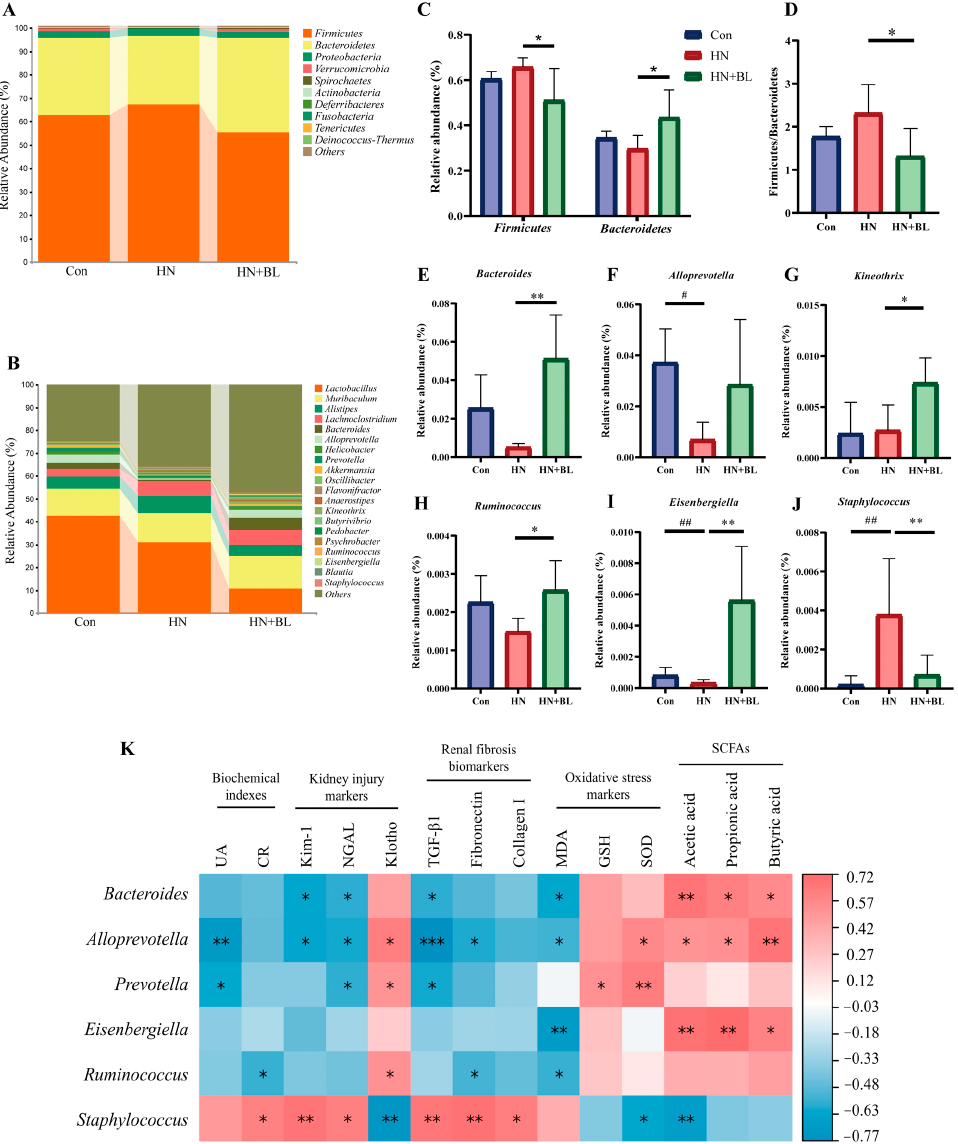
Figure 7. Effect of BL on the gut microbiota composition in the mice with HN. ( A , B ) Regulated microbial compositions at the phylum level and the genus level. ( C ) The relative abundance of Firmicutes and Bacteroidetes at the phylum level. ( D ) Firmicutes/Bacteroidetes (F/B) ratio. ( E – J ) The relative abundance of Bacteroides, Alloprevotella, Kineothrix, Ruminococcus, Eisenbergiella , and Staphylococcus . Data represent mean ± SD ( n = 5). # p < 0.05, ## p < 0.01 vs. the Con group; * p < 0.05, ** p < 0.01, vs. the HN group. ( K ) Spearman’s analysis of bacterial abundance with the determined measurements, including serum UA and CR, the renal mRNA expression of Kim ‐ 1, NGAL, Klotho, TGF ‐ β , Fibronectin and Collagen I, MDA and GSH content, and SOD activity in the kidneys, as well as the SCFAs concentrations. (* p < 0.05, ** p < 0.01, *** p < 0.001 with r > 0.5 or r < − 0.5.).